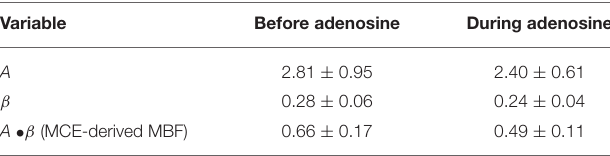
TABLE 4 | MCE variables from secondary stenosis region before and during adenosine infusion into the primary stenosis bed ( n = 8, mean ± 1SEM).